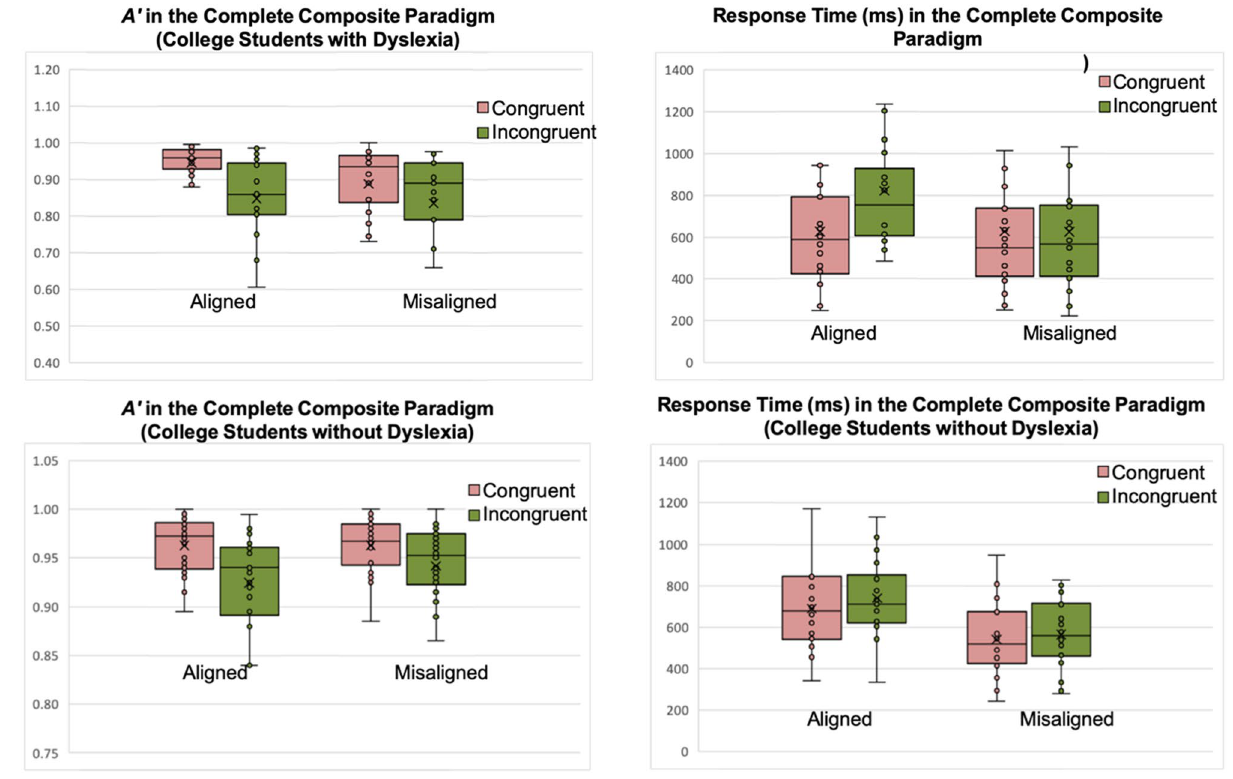
Figure 2. A ′ and Response Time (shown in congruent and incongruent trials in both aligned and misaligned conditions) in dyslexics (top) and typically developing readers